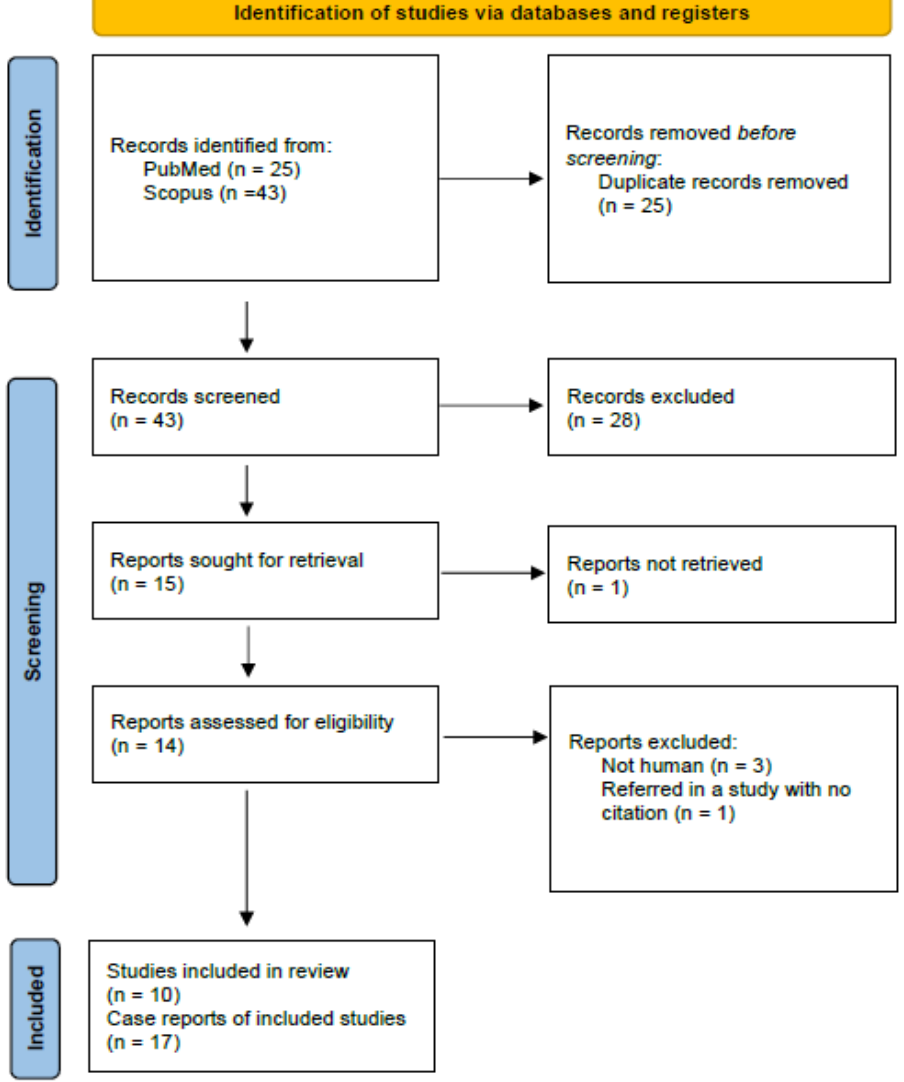
Figure 1. PRISMA flow diagram of articles related to Moellerella wisconsensis case reports.